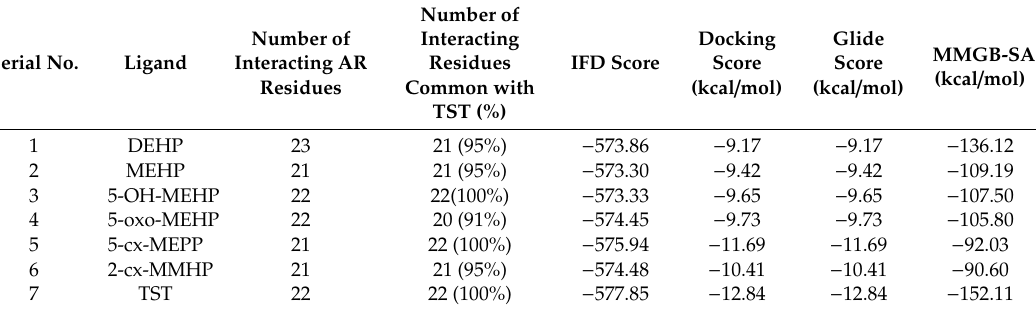
Figure 7. Ribbon diagram representing the docking pose of human androgen receptor (AR) with mono-[2-(carboxymethyl)hexyl]phthalate (2-cx-MMHP)(left panel). The interaction of ligand (2-cx-MMHP) with amino-acid residues in the binding pocket of AR (right panel). Table 2. The number of interacting residues, number and percentage of residues common with native ligand testosterone (TST), Induced Fit Docking (IFD) Score, Dock score, Glide score, and binding a ffi nity values (MMGB-SA values) of di(2-ethylhexyl)phthalate (DEHP), mono-(2-ethylhexyl)phthalate (MEHP), mono-(2-ethyl-5-hydroxyhexyl)phthalate (5-OH-MEHP), mono-(2-ethyl-5-oxohexyl)phthalate (5-oxo-MEHP), mono-(2-ethyl-5-carboxypentyl)phthalate (5-cx-MEPP), and mono-[2-(carboxymethyl)hexyl]phthalate (2-cx-MMHP) and native ligand, TST, after IDF with human androgen receptor (AR).